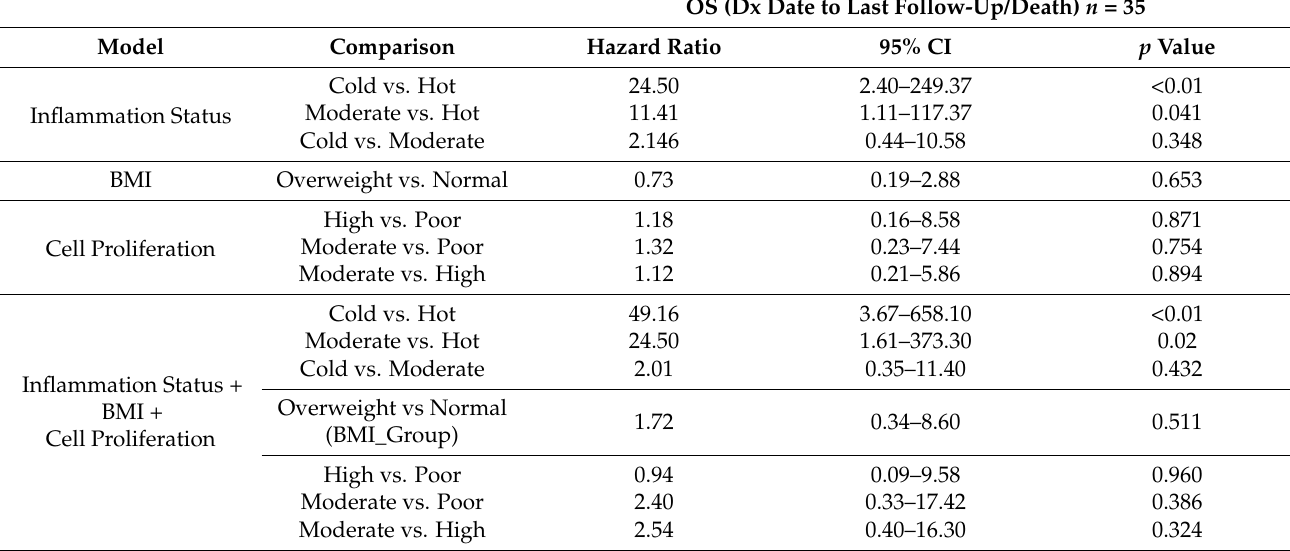
Table 2. OS in all patients.